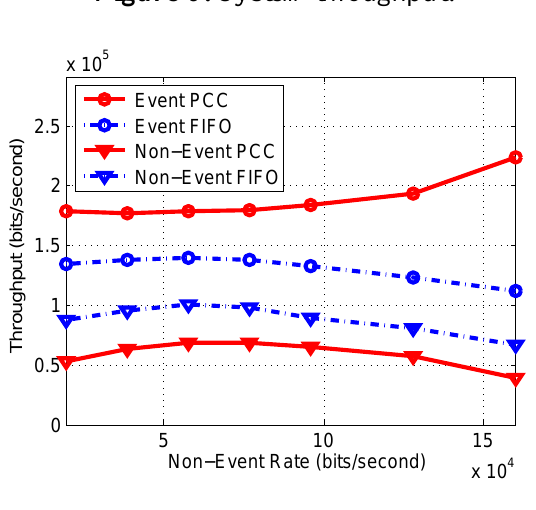
Figure 6. System throughput.